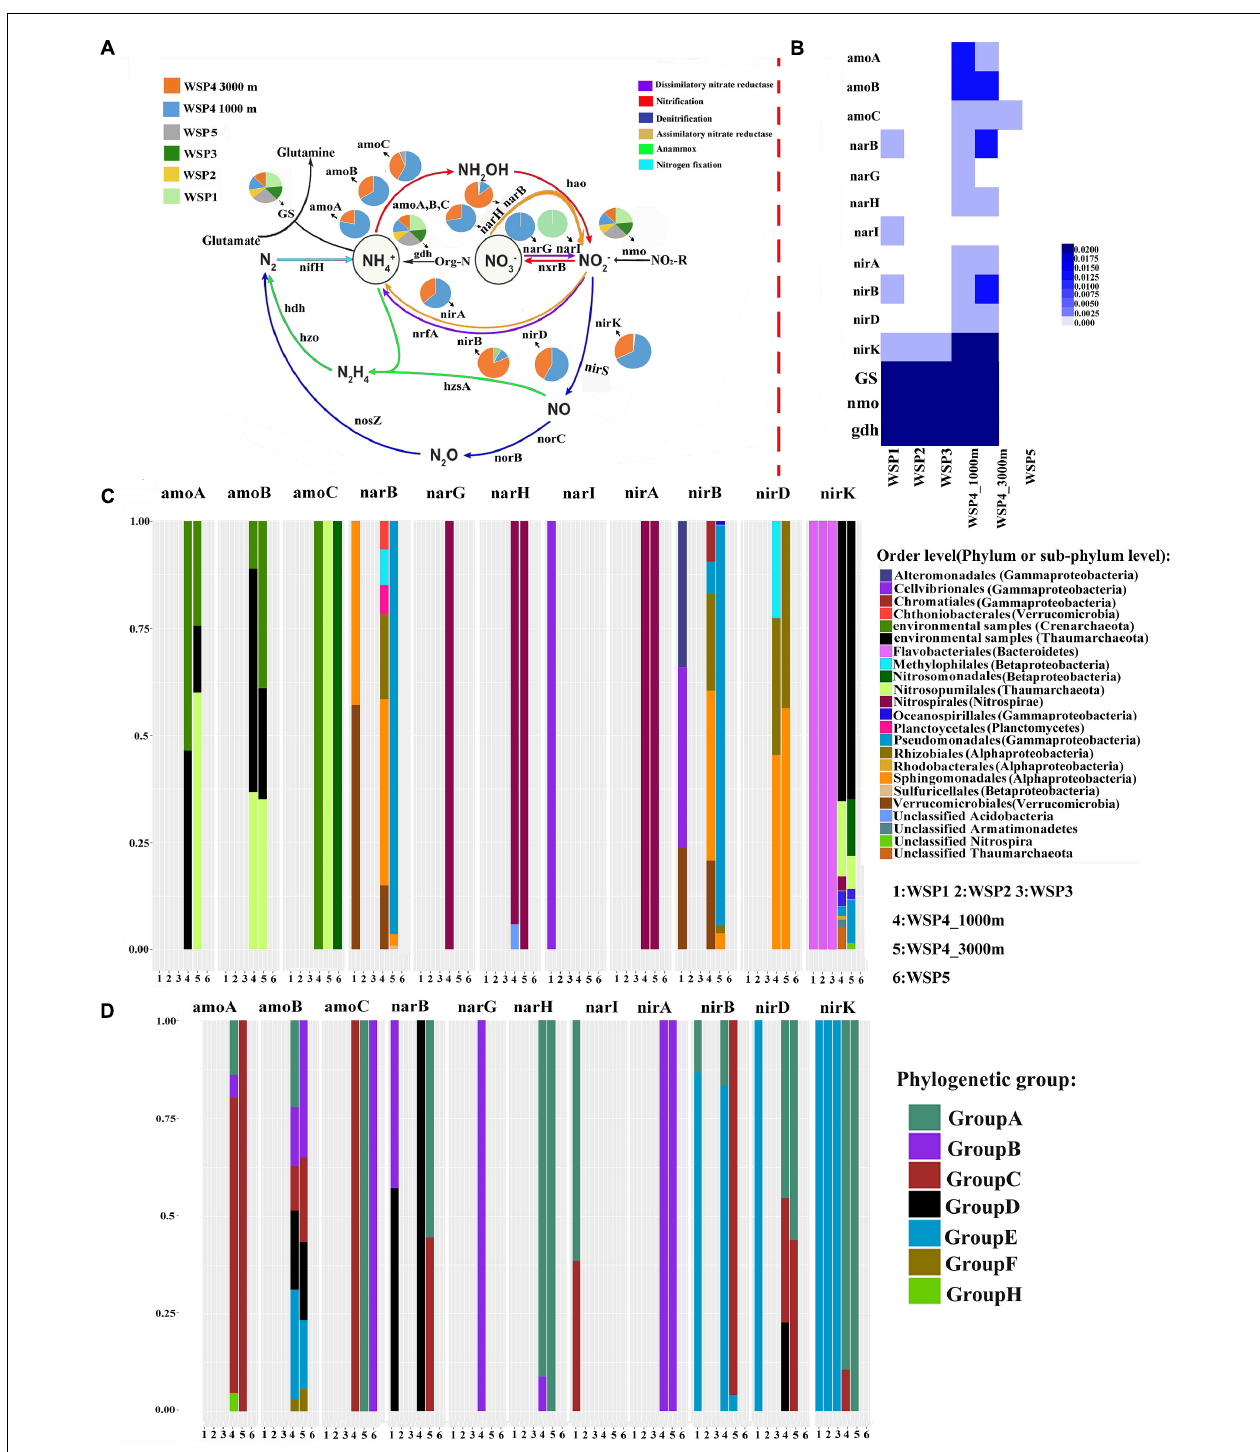
FIGURE 6 | The pie charts represent the relative abundance of nitrogen metabolism related genes, which was calculated through dividing the sum of a gene’s coverage in an individual sample by the sum of this gene’s coverage in all samples (A) . The absolute abundance of each gene in each sample was calculated through dividing the coverage of an individual gene by the summed coverage of all functional genes, and the final value was squared (B) . The microbial taxa of the genes and its relative abundance in each sample (C) . The genotype of the key genes and its relative abundance in each sampling site (D) . The classification of each genotype was based on the phylogenetic tree of the reads derived from the metagenomic data and the reference sequences downloaded from NCBI. The phylogenetic tree was generated using the maximum likelihood method with 1,000-time bootstraps.